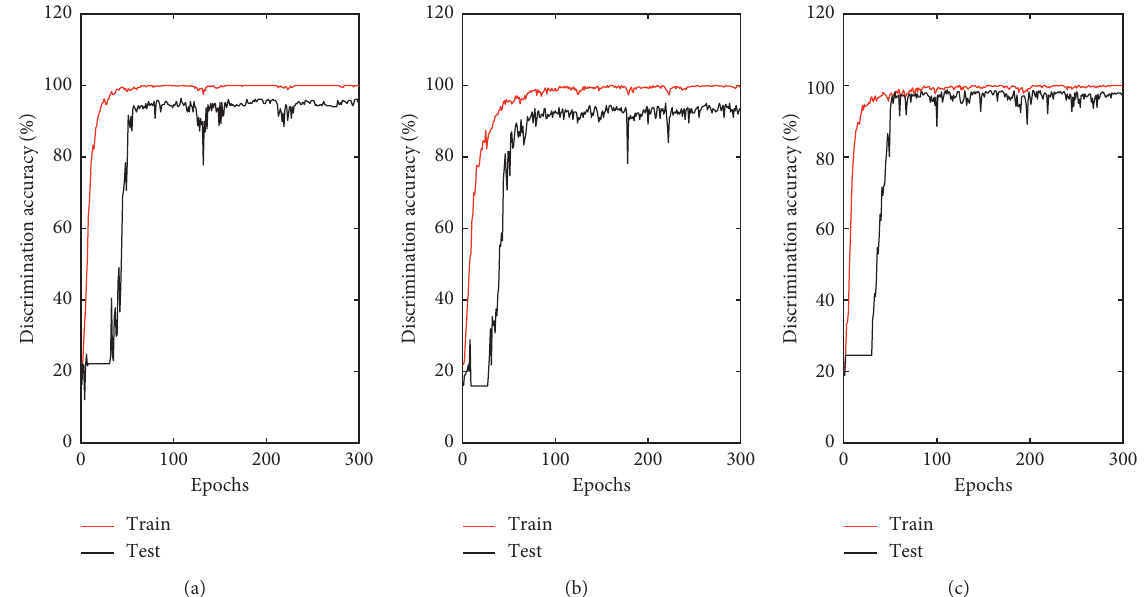
Figure 5: Discrimination accuracy across epochs of CNN model: (a) upper leaf, (b) middle leaf, and (c) lower leaf.